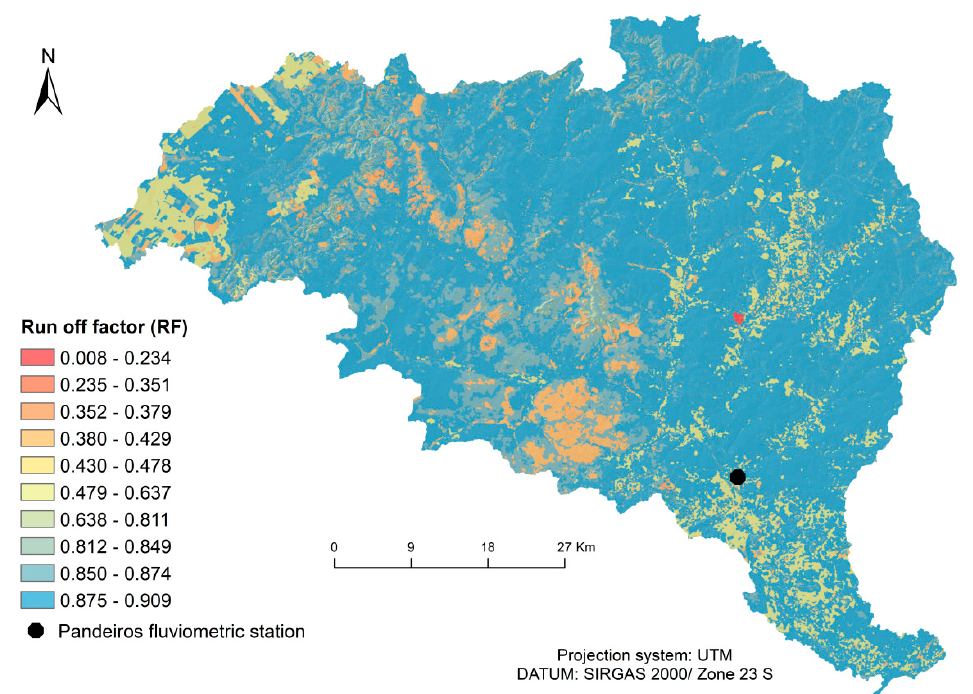
Figure 9. Spatial distribution of runoff factor in the Pandeiros River basin.